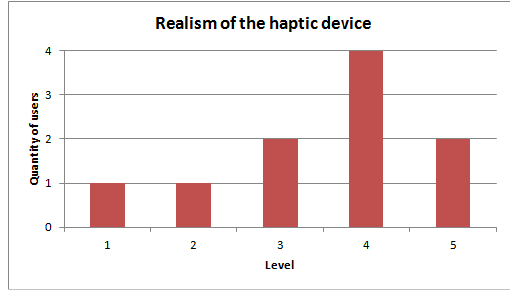
Figure 21. ViMeTGame evaluation question about the realism level of the haptic device. Scale: 1 to “None”and 5 to “Full sensation